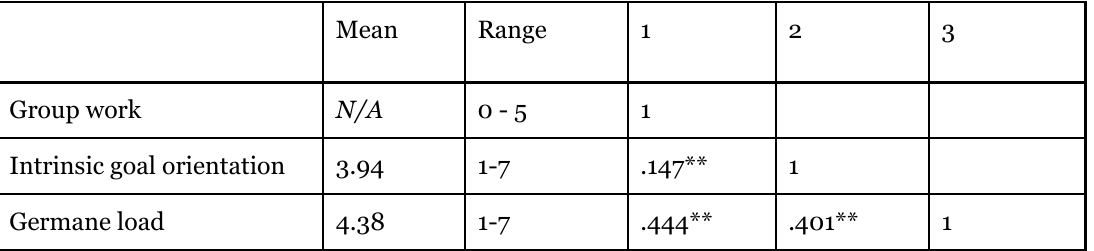
Descriptive Statistics and Correlations Between the Main Variables (n = 2042) Mean Range Group work